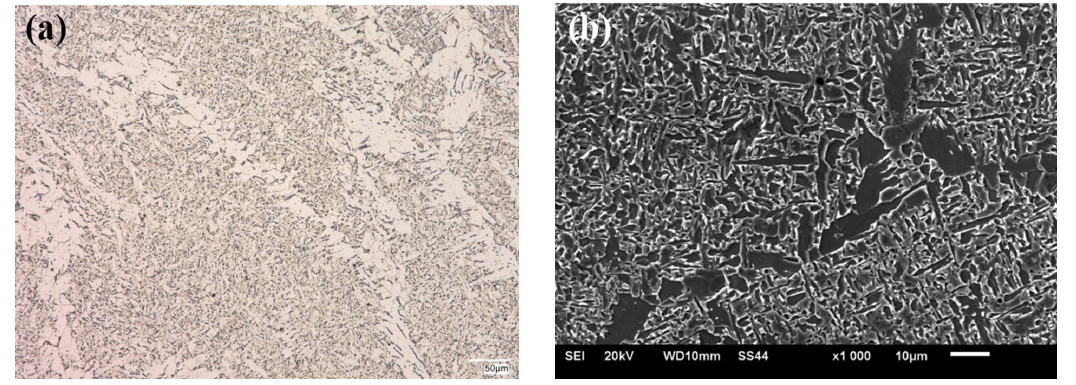
Figure 8. Microstructure of weld, ( a ) OM; ( b ) SEM.